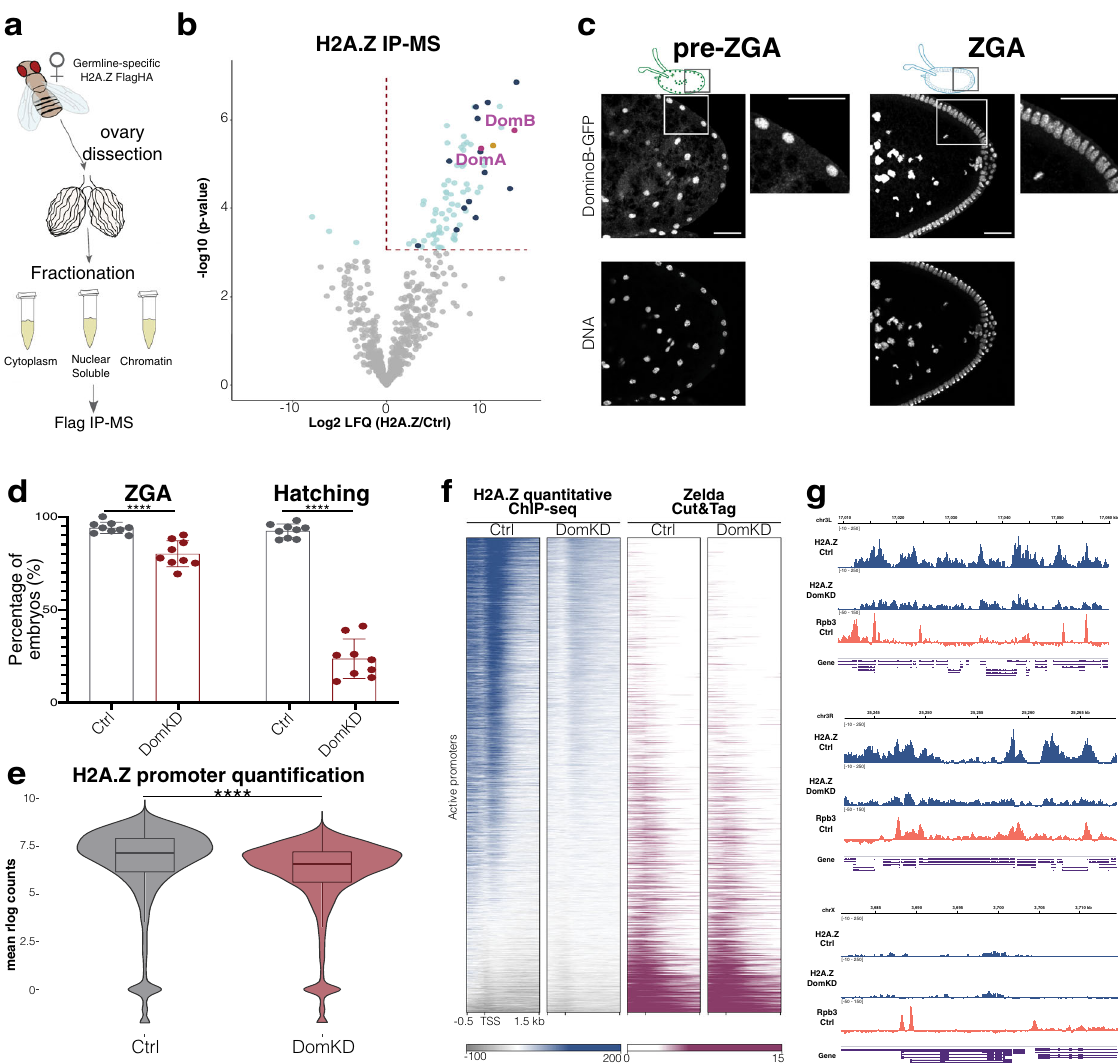
Fig. 2 Domino is the main histone chaperone for H2A.Z on TSS. a Experimental setup for H2A.Z IP-MS. b Volcano plot showing the -log10 p-value ( y axis) compared to the enrichment over control (log2 LFQ) of the anti-Flag IP followed by MS. A fi tted linear model with padj for multiple-hypothesis (Benjamini – Yekutieli, two-sided) was used to obtain signi fi cantly enriched or depleted proteins, colored in cyan (-log10 padj value >1.3). The red dotted line frames signi fi cantly enriched proteins (log2 LFQ > 0). Domino isoforms are highlighted in magenta. Dark blue denotes signi fi cantly enriched members of the Tip60 complex. Yellow is Arp6, a DominoB 34 interactor. n = 3 biological replicates per condition. c Representative immuno fl uorescence of DominoB- GFP in pre-ZGA (left, NC10) and ZGA (right, NC14) embryos. Insets show a magni fi cation of the GFP signal. Scale bar = 40 μ m. See Supplementary Fig. 2a for DomA staining. d Phenotypic characterization of Ctrl and DomKD embryos. Percentage of embryos (left) reaching the ZGA stage or (right) completing embryogenesis (Hatching) ( p -value < 0.0001, two-tailed Mann – Whitney test). n = 453 embryos for Ctrl and n = 465 embryos for DomKD embryos. Data are presented as mean values ± SD. Source data are provided as a Source Data fi le. e Violin plot of the mean rlog transformed counts of H2A.Z quantitative ChIP-seq on active promoter regions in Ctrl and DomKD embryos at ZGA. Box plot inside depict the median and the interquartile range (IQR) from the 1 st to the 3 rd quartile. Whiskers indicate the upper (Q3 + 1.5*IQR) and lower edge (Q1 − 1.5*IQR). Welch two sample t -test, two-sided, p -value < 2.2e − 16. n = 2 biologically independent experiments per genotype. f Heatmap of H2A.Z quantitative ChIP-seq signal (left 2 columns) and Zelda Cut&Tag signal (right 2 columns) on active promoters, sorted according to H2A.Z signal on Ctrl embryos at ZGA. Averaged library size corrected signal tracks from two replicates were used for Zelda. g Screenshots of genome browser tracks (Integrative Genomics Viewer, IGV) 114 showing H2A.Z quantitative ChIP-seq signal in Ctrl and DomKD embryos at ZGA, Rpb3 signal in Ctrl embryos represents RNA Pol II coverage on the same regions. (Top) Chr3L:17,010,000 – 17,060,000. (Middle) Chr3R: 25,243,000 – 25,265,000. (Bottom) ChrX: 3,680,000 – 3,715,000.